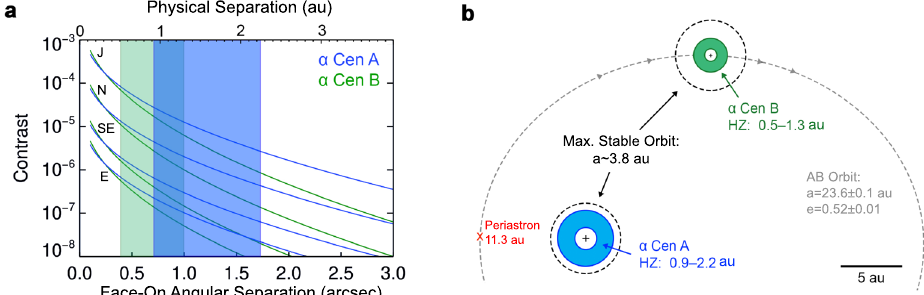
Fig. 1 Simulated planet brightness and basic properties of the α Centauri system. a N -band (10 – 12.5 μ m) contrast vs. angular separation of planets around α Centauri A (blue) and B (green), assuming face-on circular orbits, a Bond albedo of 0.3 and internal heating that provides an additional 10% of the planets ’ equilibrium temperatures. The curves correspond from bottom to top to planetary radii equivalent to that of Earth, a Super-Earth (1.7 × Earth ’ s radius, R ⊕ ), Neptune, and Jupiter. The blue and green shaded regions show the location of the classical habitable zones around α Centauri A and B, respectively 13 . b Diagram of the orbital properties and approximate habitable zones of the α Centauri AB system. Note that this diagram does not show the 79° inclination of the orbit as seen from Earth, or the tertiary dwarf star, Proxima Centauri, at ~10 4